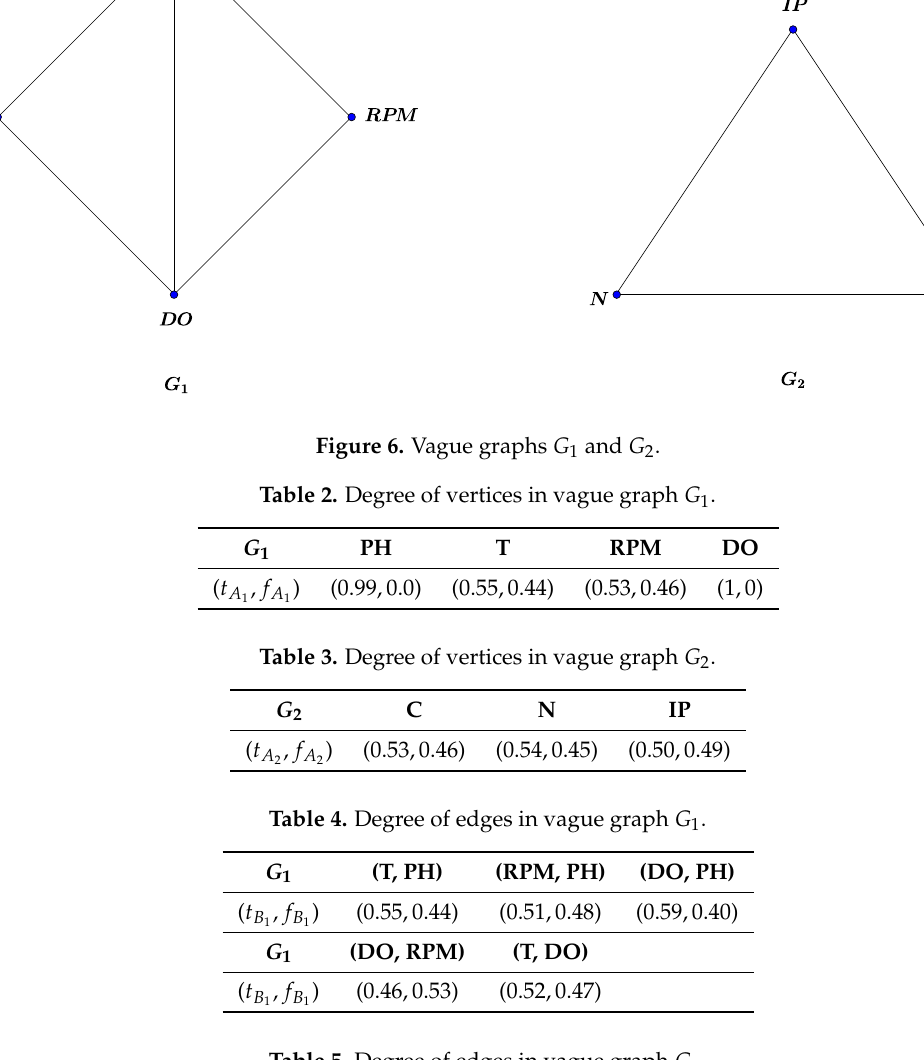
Table 5. Degree of edges in vague graph G 2